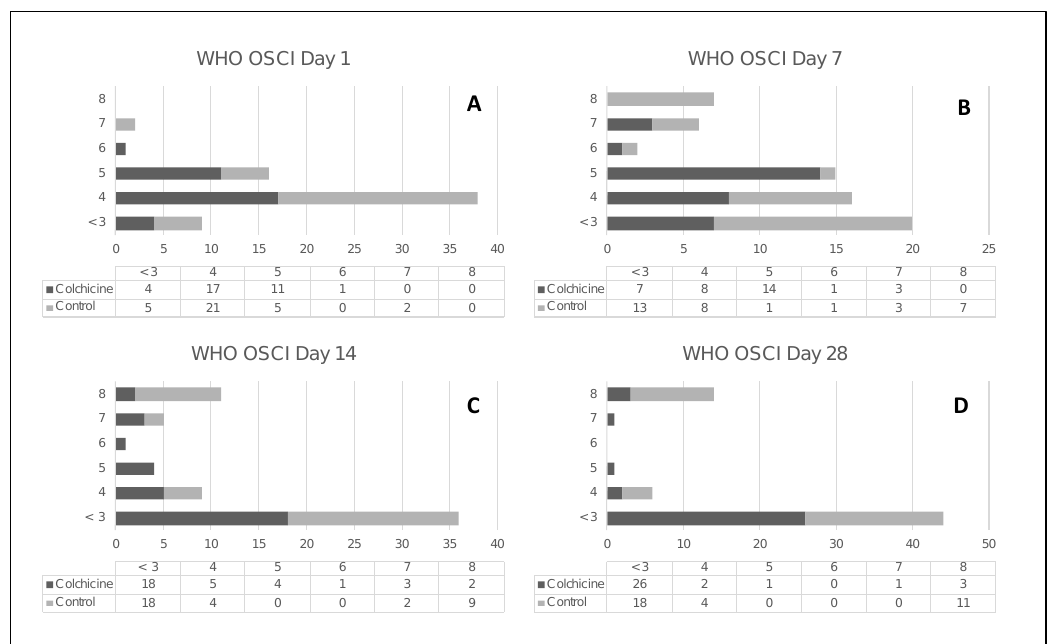
Figure 3. Figure ( A – D ) provide the distribution of WHO OSCI score at baseline and on days 7, 14, and 28. At baseline, only three patients required mechanical ventilation (WHO OSCI score above 6; colchicine = 1, control = 2). The last observation carried forward for each evaluation was